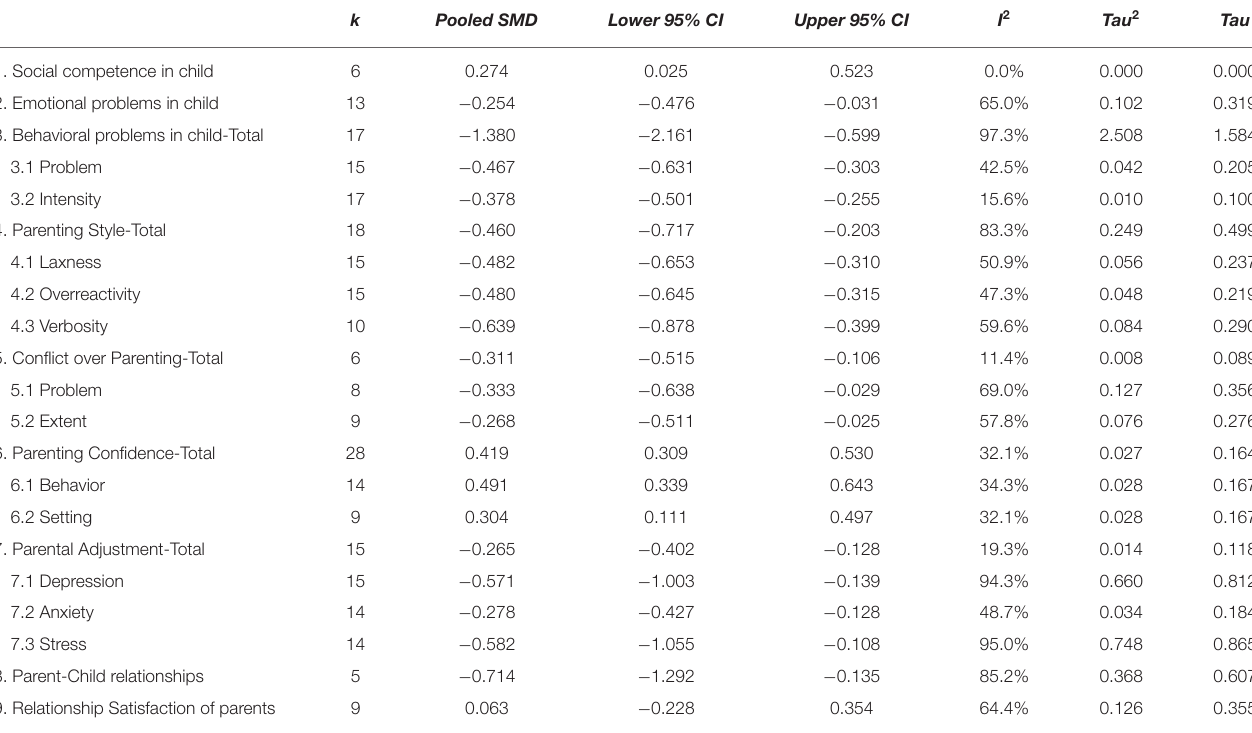
TABLE 2 | The overall effect size of Triple P on the